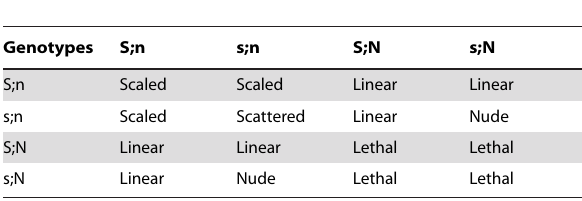
Table 1. Punnett square showing the expected distribution of offspring scale pattern phenotypes from a cross between two common carp brooders heterozygous for both loci involved in scale formation based on Kirpichnikov’s